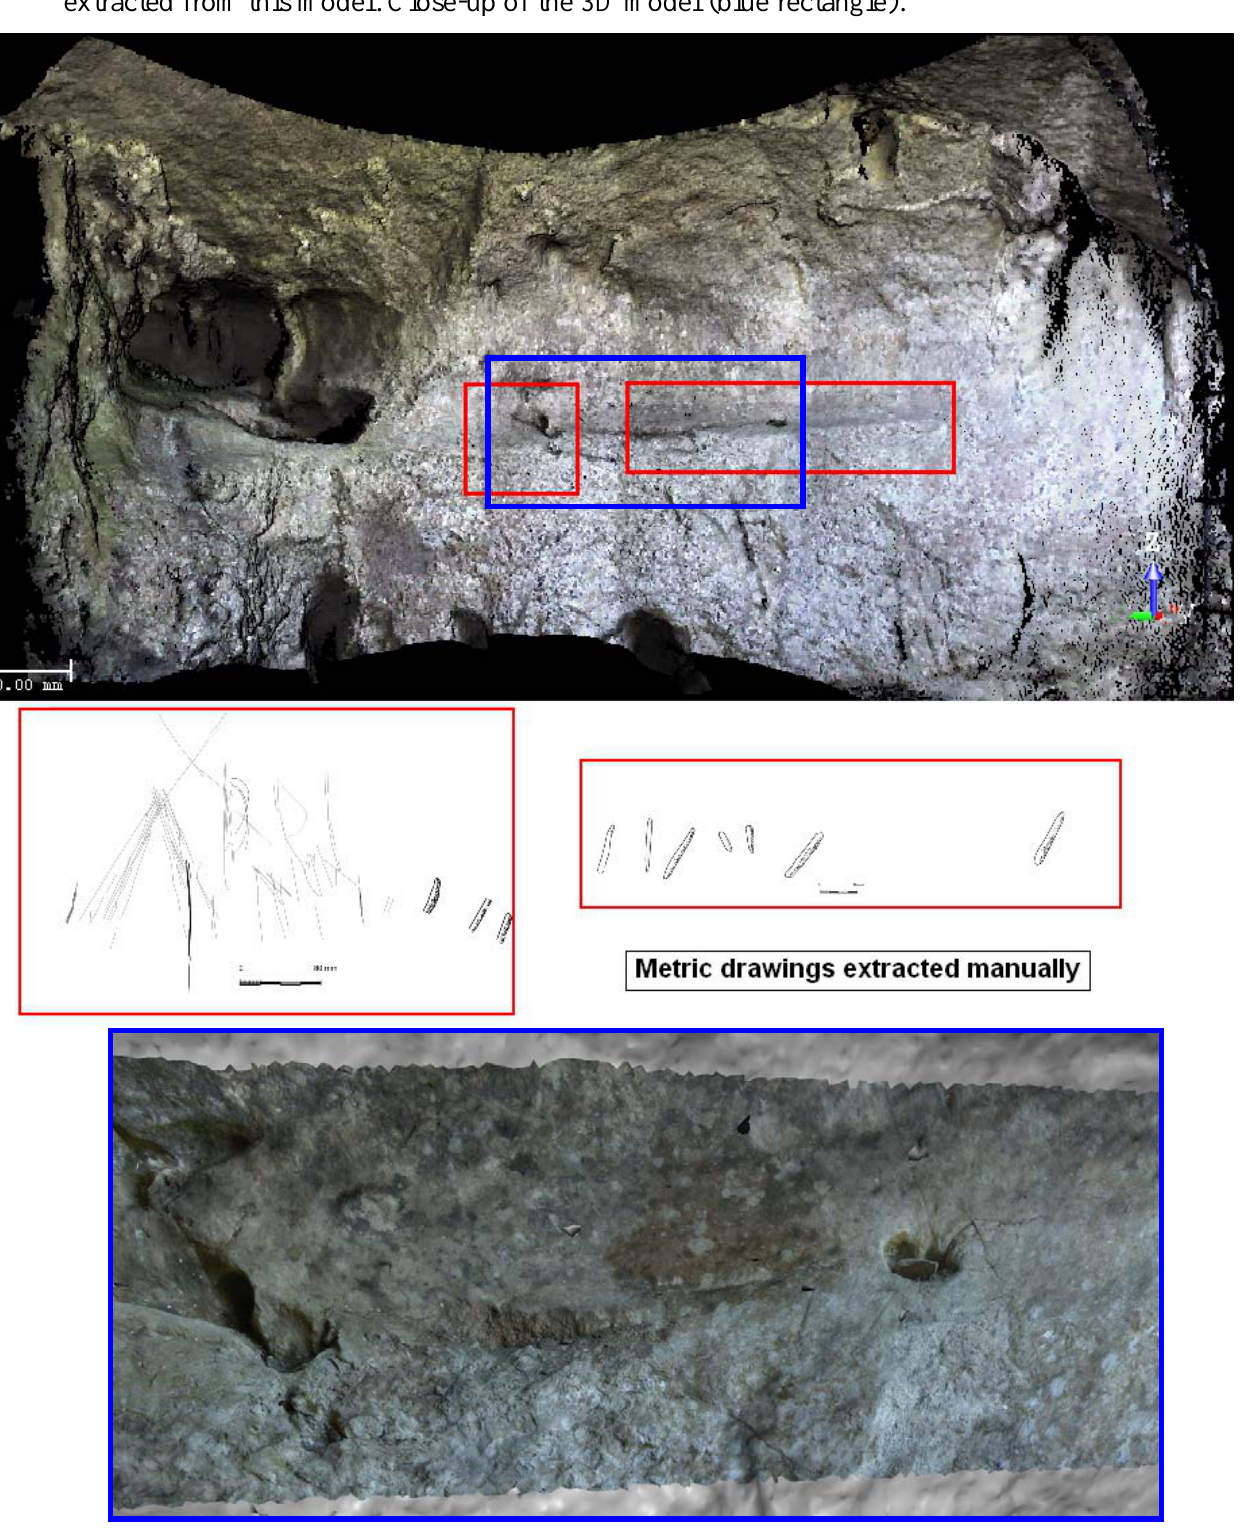
Figure 3. Detailed 3D hybrid model together with vector scale drawings (red rectangles) extracted from this model. Close-up of the 3D model (blue